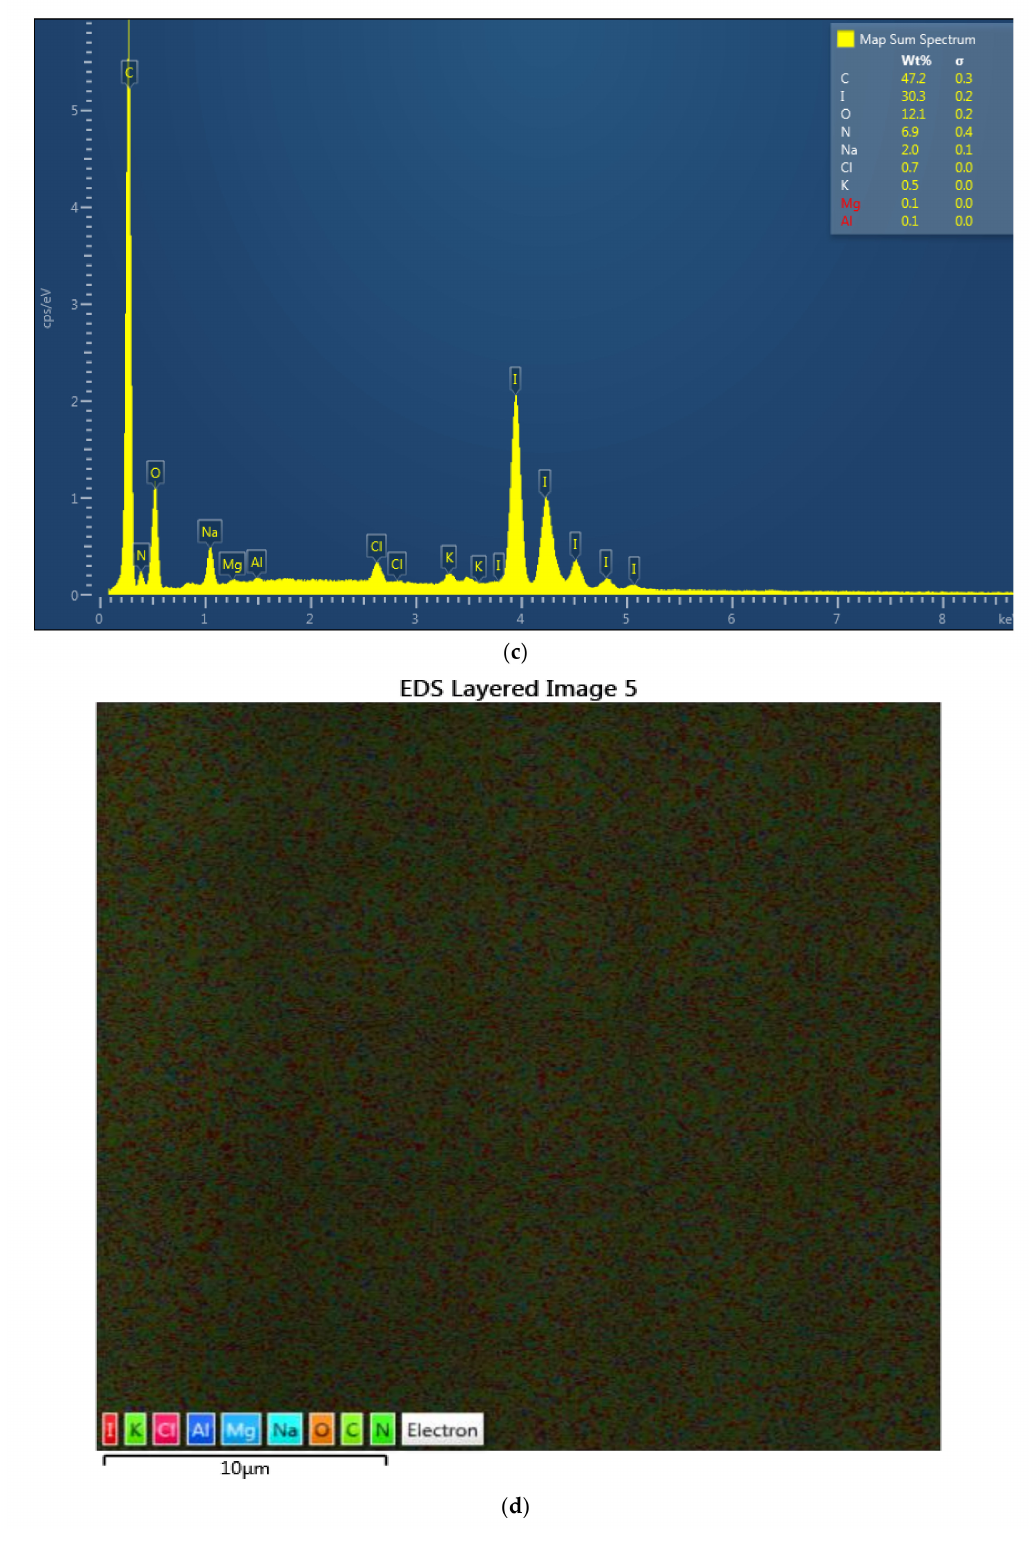
Figure 2. Energy dispersive spectroscopy (EDS) and EDS layered images of the two complexes.